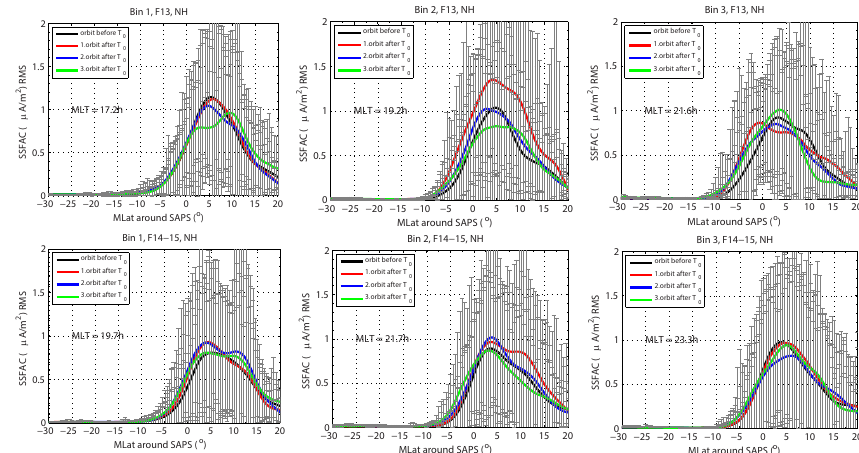
Figure 4. As Fig. 3, but for the intensity of small- and medium-scale FACs (SSFACs).